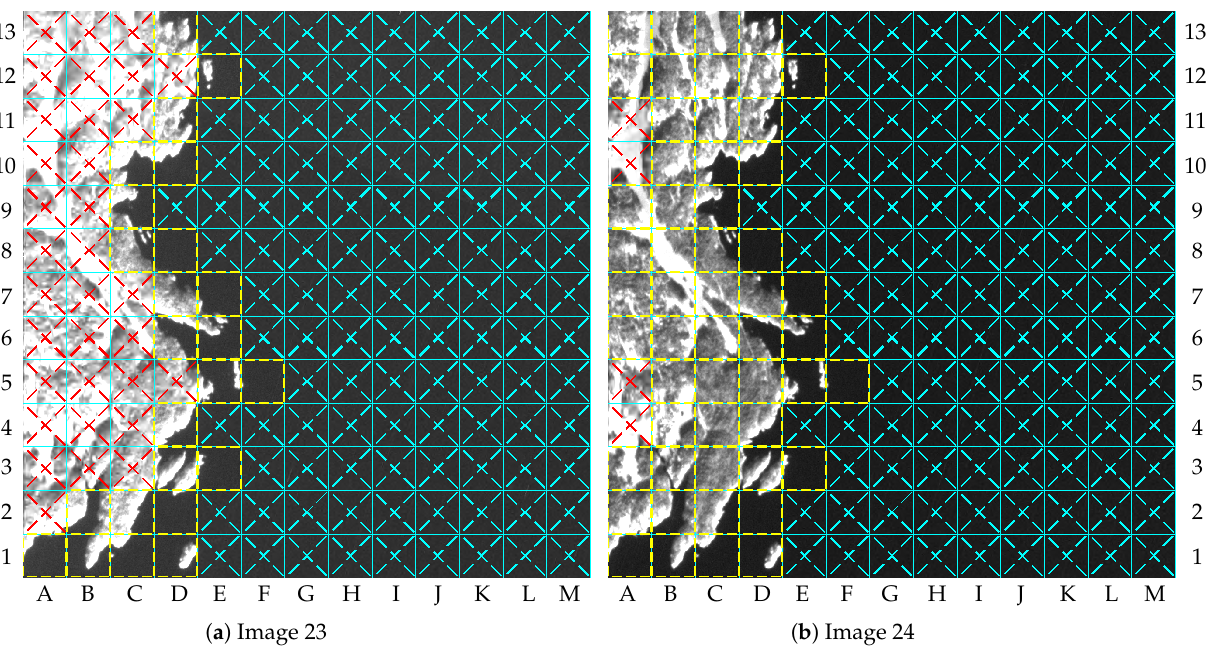
Figure 18. Labeled tiles of images 23 and 24 (NIR band truncated at 4000): ( a ) image 23; ( b ) image 24.